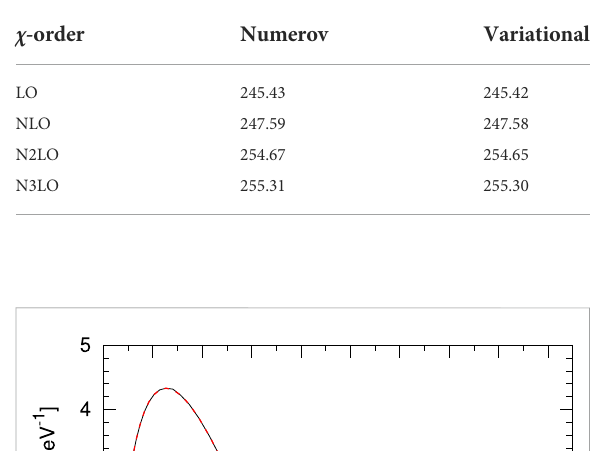
TABLE 2 Total doublet capture rate in the 1 S 0 nn channel, Γ D ( 1 S 0 ) in s − 1 , calculated using either the Numerov or the variational methodstoobtainthedeuteronandthe nn scatteringwavefunctions. Here, we report the results up to the digit for which the two methods differ. The NVIa potential and consistent currents at the various chiral order are used, and the axial charge radius is taken to be (cid:2) 0 . 46 fm 2 . r 2 A